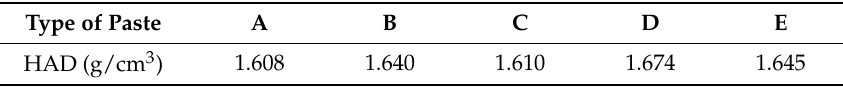
Table 6. Average hydrostatic apparent green density (HAD) for each paste (g/cm 3